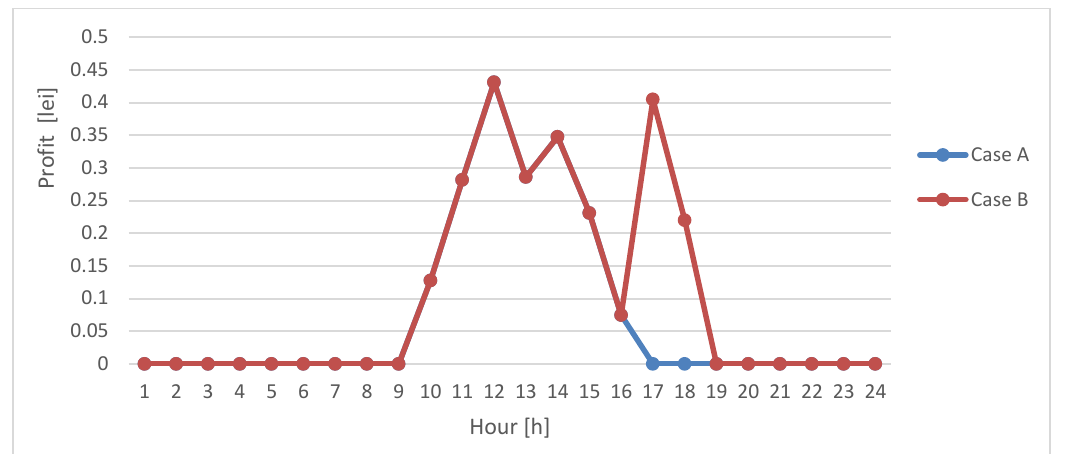
Figure 4. Power cost for the consumer.